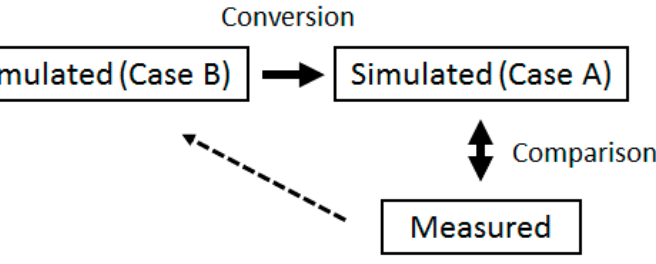
Figure 12. Block diagram of the measuring method of the proposed antenna.